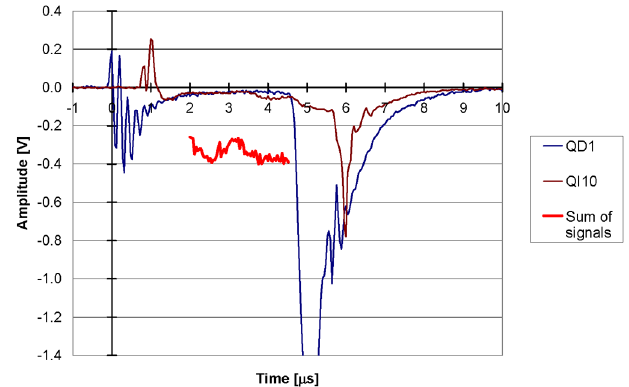
FIG. 17. (Color) Electrode monitors for the first (blue) and last (brown) electrostatic quadrupoles of the transport section for an 80% fill factor case. In red is the sum of all ten quadrupole pickup signals in the middle of the beam pulse. This sum is representative of the beam loss through scraping and beam/ background gas